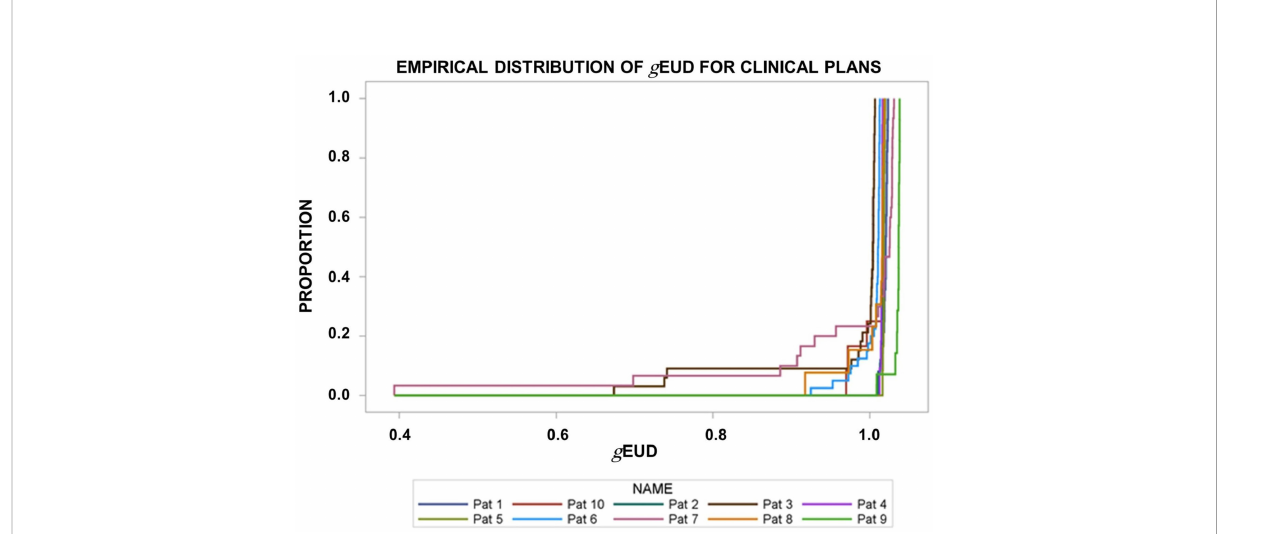
FIGURE 1 Empirical distribution functions of the generalized equivalent uniform dose ( g EUDi) for the deformed CTV i on the pre-fraction cone beam CTs normalized by the prescribed dose. The clinically applied dose distributions were used. There was signi fi cant interpatient heterogeneity ( p < 0.0001, Kruskal – Wallis